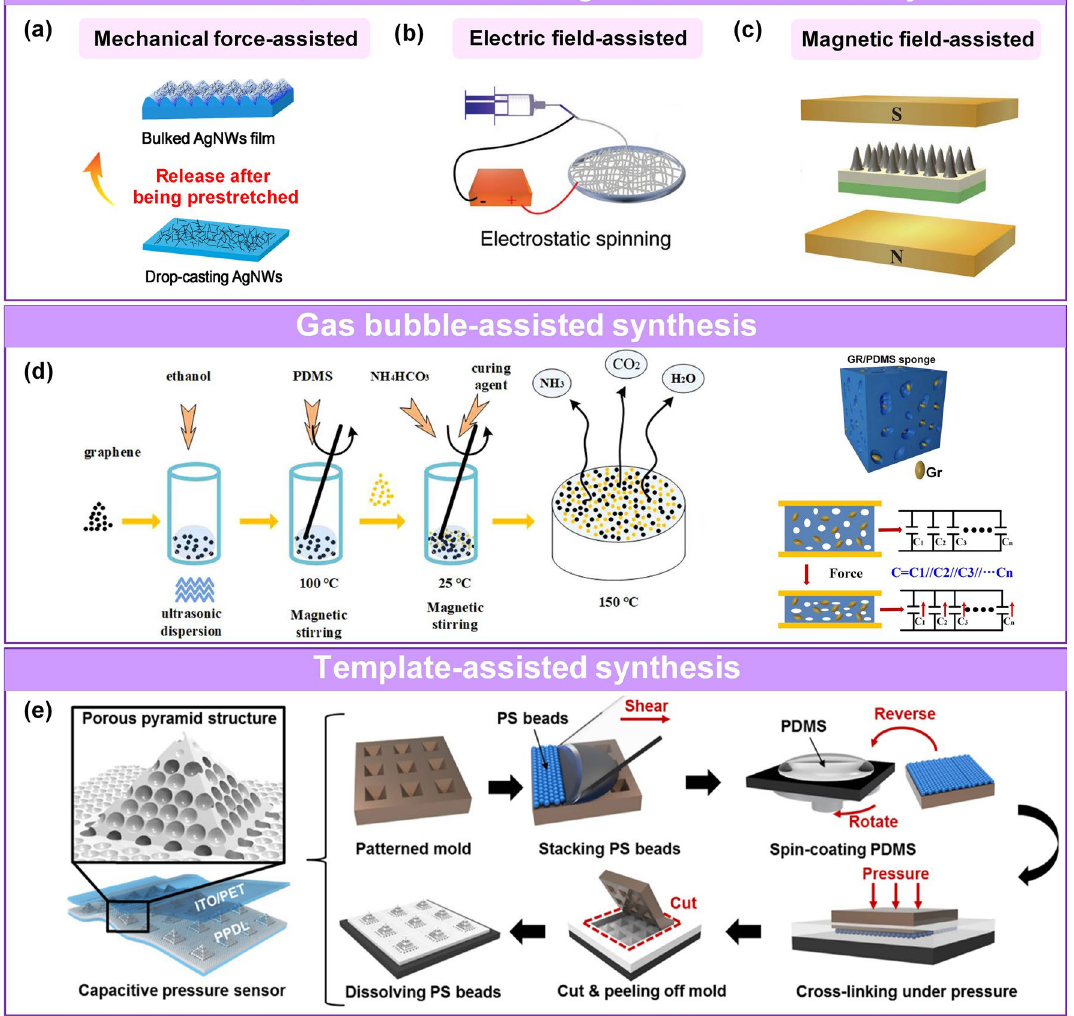
Fig. 15 Assisted synthesis of structured sensing materials. a Fabrication process of wavelength wrinkles based on pre-stretched and release [66]. Copyright (2017) American Chemical Society. b Schematic illustration of the preparation of silk nanofiber membranes by electrospinning [118]. Copyright (2019) Wiley–VCH. c The microneedles formation of magnetic particles under magnitude [119]. Copyright (2020) Wiley– VCH. d Porous structure based on gas-assisted self-foaming [64]. Copyright (2019) The Authors. e Porous pyramid structure fabricated by pyra- mid structure of silicon mold and PS beads sacrificial template [121]. Copyright (2019) American Chemical